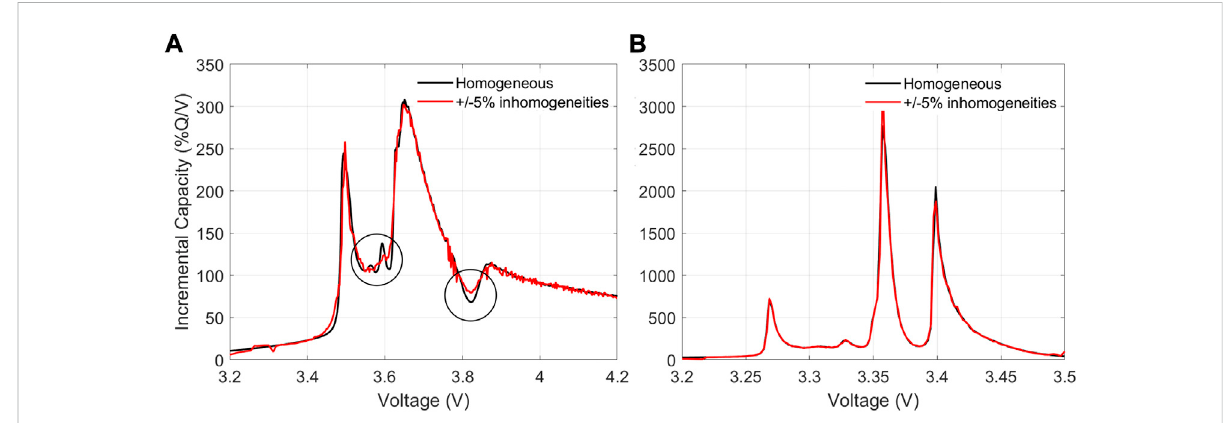
FIGURE 9 Comparison of the voltage response of a homogeneous cell vs. a cell with ±5% of LLI, LAM PE , and LAM NE for (A) a GIC/NMC cell and (B) a GIC/ LFP cell.